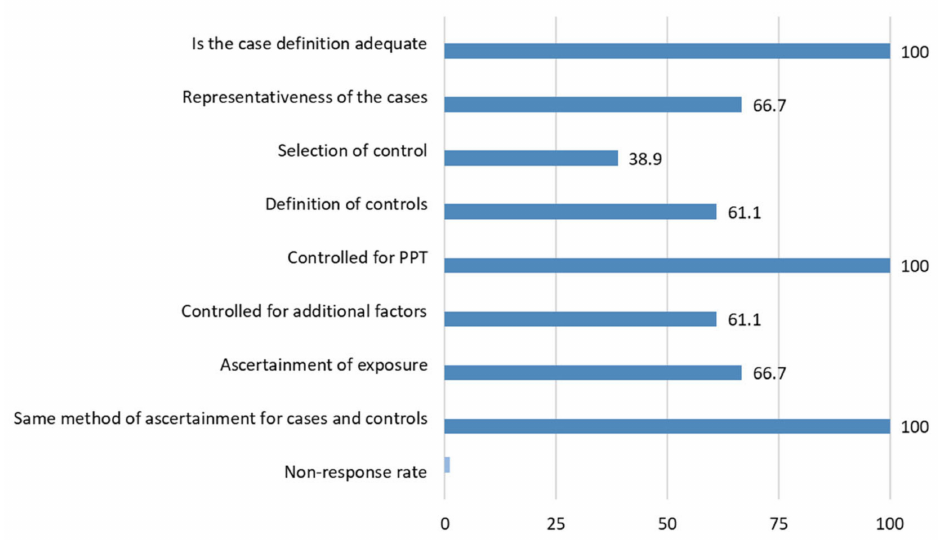
Figure 4. Percentage of assigned stars in migraine